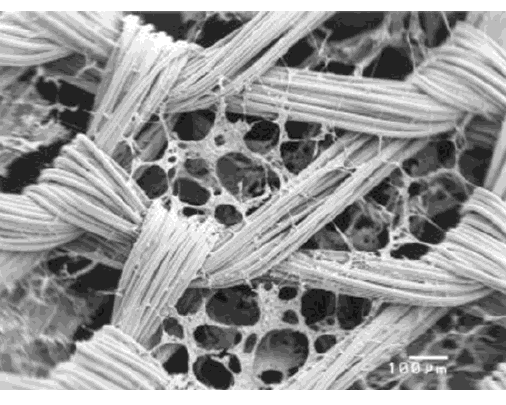
Figure 4. The SEM images of chondrocytes on the PLGA/collagen web after 1 day culturing, reprinted with permission from [121]. Copyright 2003 Wiley Periodicals,